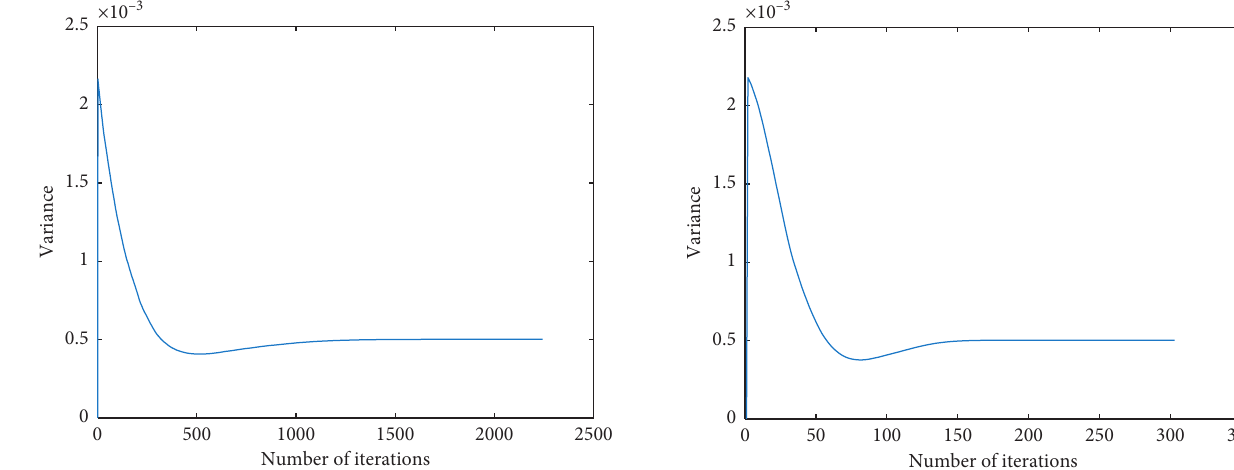
Figure 10: Changes in the variance of Nadam algorithm.